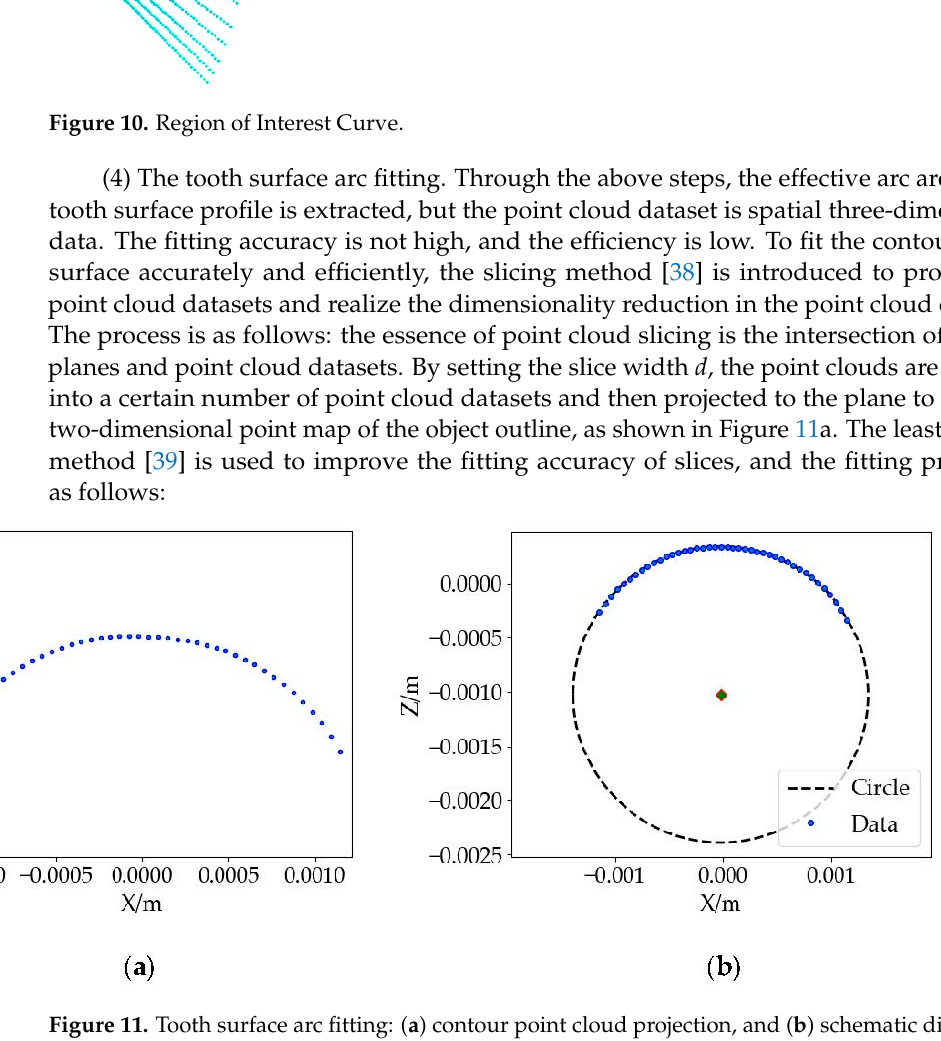
Figure 12. Synchronous belt tooth profile measurement system composition. 3.2. Measurement Data The arc tooth synchronous belt is placed on the platform, and the point cloud on the surface of the arc tooth synchronous belt is obtained by the line structured light sensor. The raw point clouds are preprocessed, and the plane and region of the interest curve are obtained by dividing the point cloud. As in the measurement plan in Section 2, the tooth profile parameter measurement of the synchronous belt is completed. To verify the accuracy and stability of our method, the result of the projection and the manual method were compared. Taking the manual measurement data as the stand- ard, the error analysis of the projection method and the method in this paper is carried